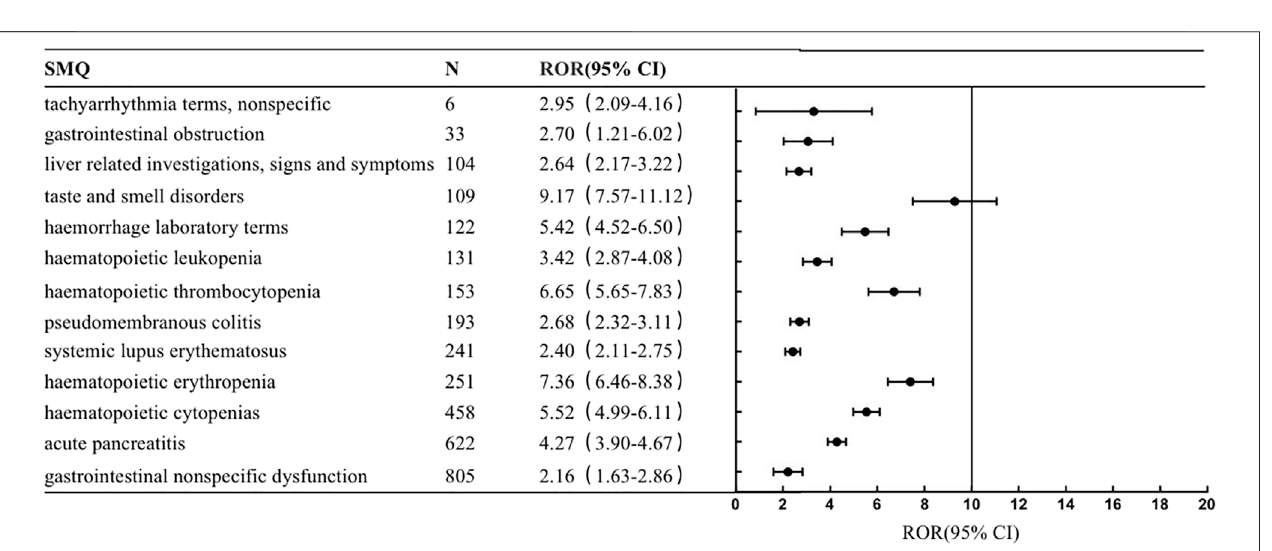
FIGURE 2 | The positive signal distribution of Rucaparib using standardized MedDRA queries.